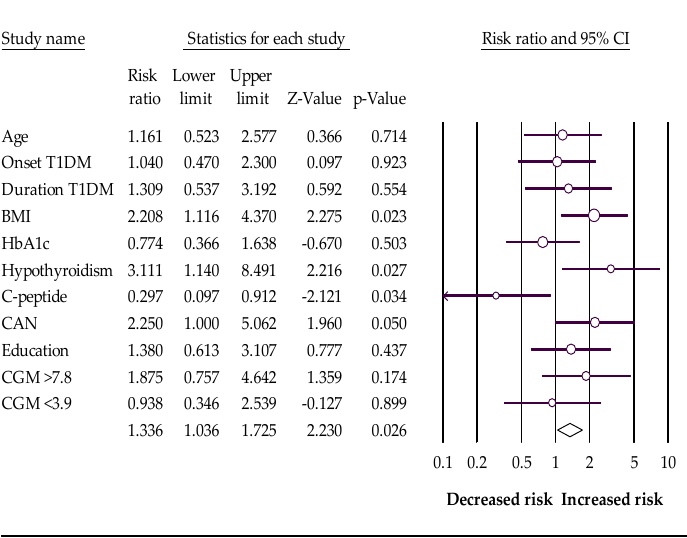
Figure 1. The Forest plot represents the relative risks for total cognitive function (Q-value 16.862, df 10, p -value 0.077, I 2 40.695). The following data are presented: age, age of onset disease, duration of disease, BMI, HbA1c %, subclinical hypothyroidism, C-peptide preservation, cardiovascular autonomic neuropathy (CAN), level of education, percentage of glucose concentration >7.8 mmol/L, and percentage of glucose concentration <3.9 mmol/L measured with a continuous glucose monitor (CGM). Empty circles represent the relative risk of effect for each category; horizontal lines around circles indicate confidence intervals, and the central vertical line represents the magnitude of the null effect.